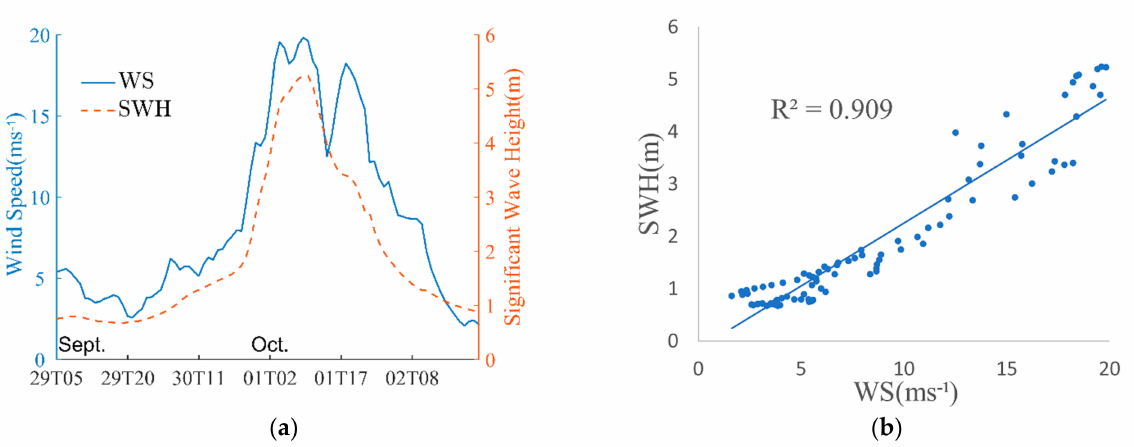
Figure 12. Wind speed (WS) and significant wave height (SWH): ( a ) The variation in wind speed (WS) and significant wave height (SWH); ( b ) correlation diagram of WS and